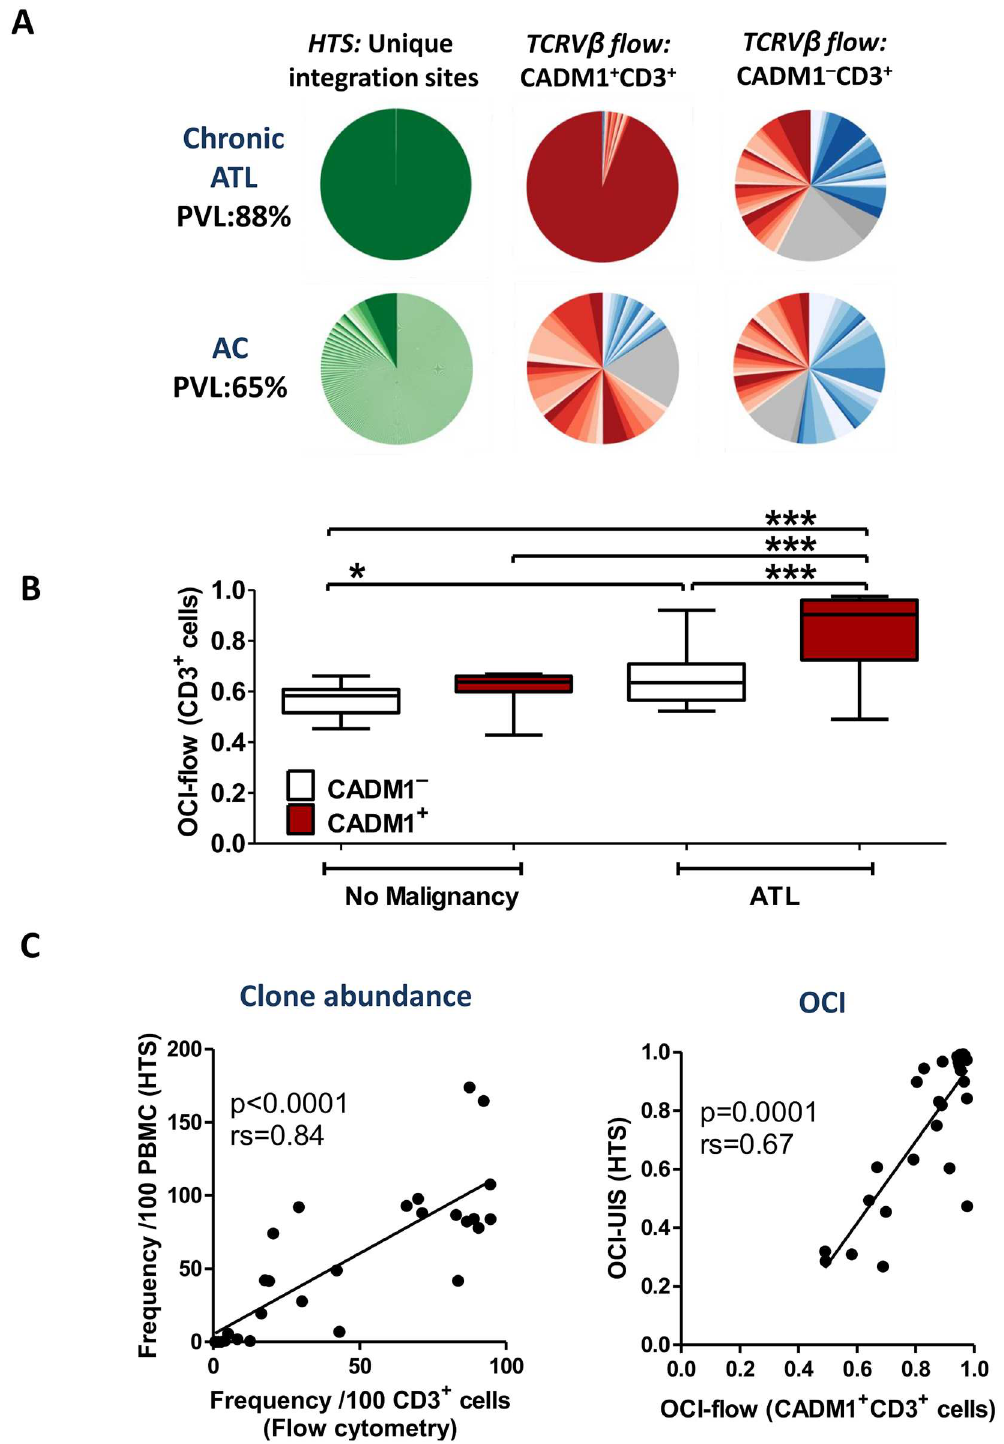
Fig 1. Flow cytometric staining of TCRV β subunits revealsclonal expansions in ATL patients. Cryopreserved PBMCs from 52 individuals(28 ATL; 11 AC; 13 HAM) were thawed and stained with a viabilitystain followedby antibodiesspecific for 24 TCRV β subunits, CD3, CD4, CD8, CADM1, CD7, CD127, CD25 and CCR4. Proviral genomicintegrationsites were mappedby LM-PCR and HTS. OCI was calculatedusing the Gini index, as previouslydescribed[12]. (A) Representative data from one individualwith chronic ATL, and one high PVL AC.